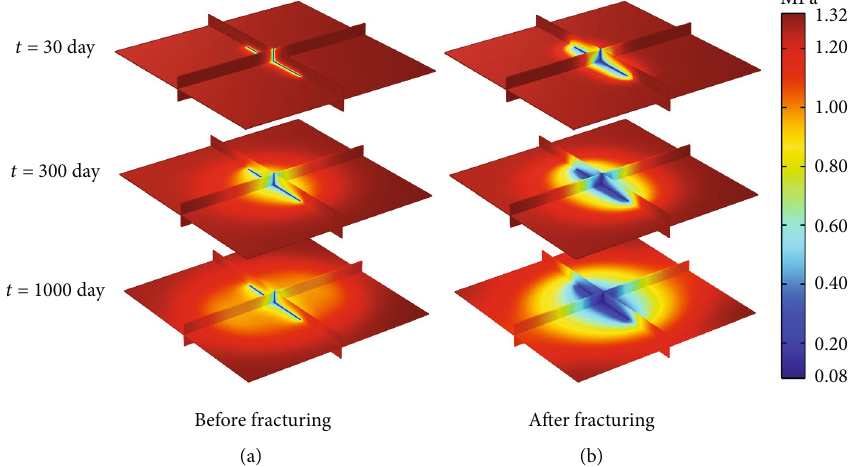
Figure 16: Distribution of gas pressure before fracturing and after fracturing at di ff erent times: (a) distribution of gas pressure before fracturing and (b) distribution of gas pressure after